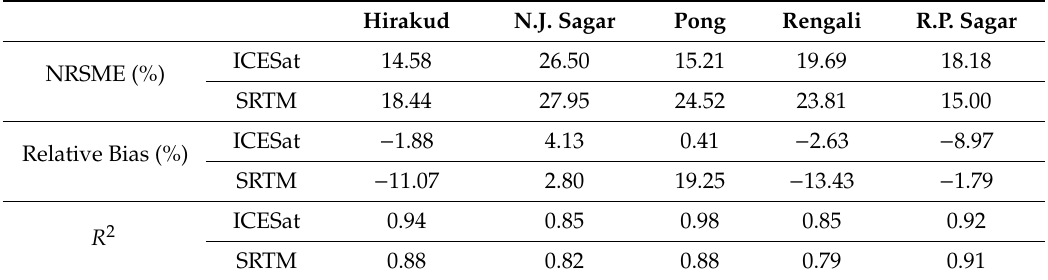
Table 3. Comparison of the validation results between the MODIS-SRTM and MODIS-ICESat approaches. Hirakud Pong Rengali